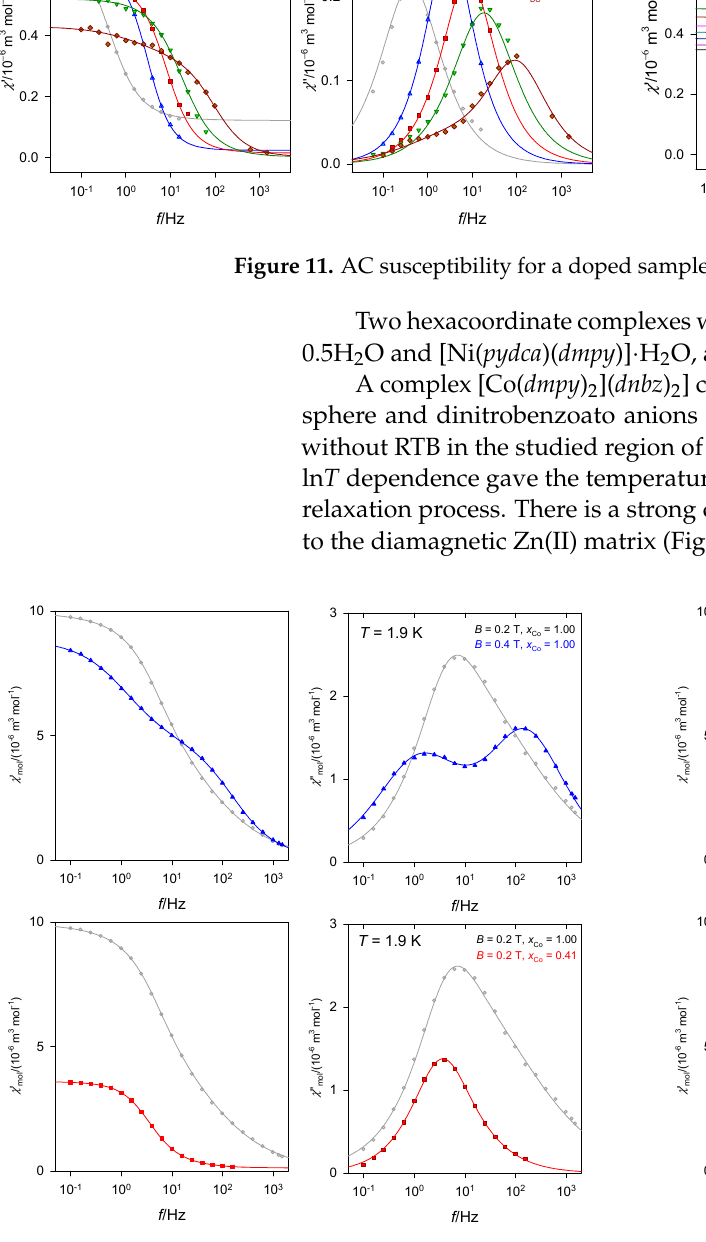
Figure 12. AC susceptibility for [Co( dmpy ) 2 ]( dnbz ) 2 ] ( x Co = 1.00) and its doped analogue C 28 H 24 Co 0.41 N 6 O 16 Zn 0.59 ( x Co = 0.41). Data adapted from ref. [27]. 2017, Royal Society of Chemistry.